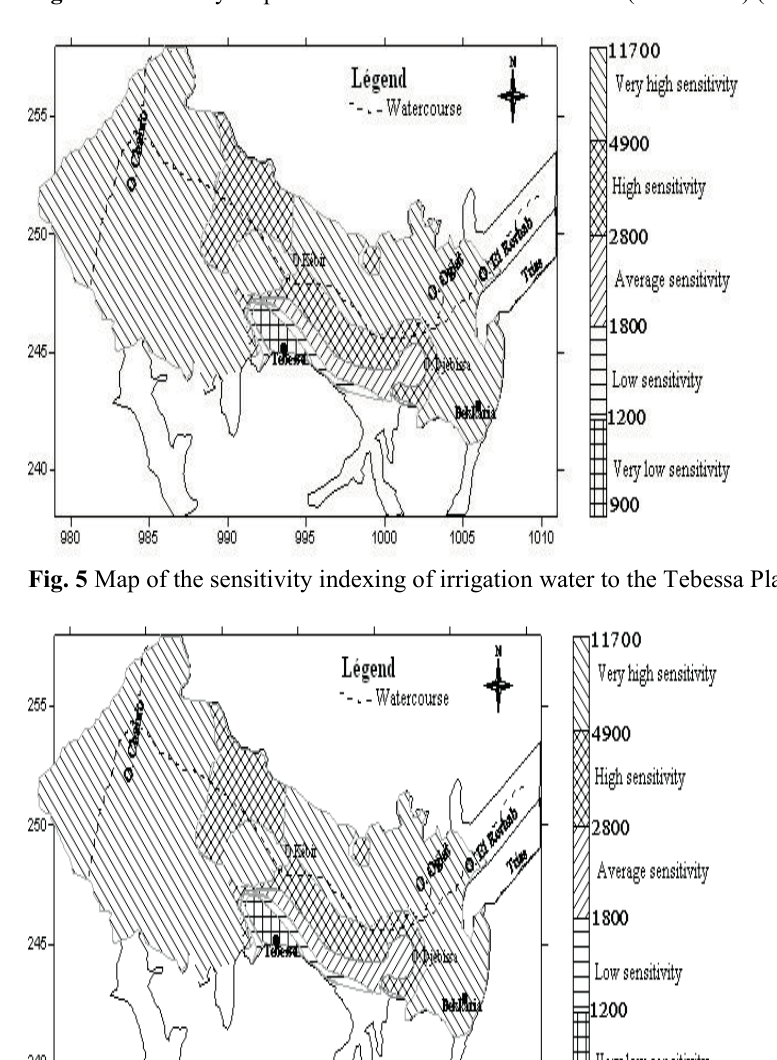
Fig. 4 Vulnerability map of the waters of the Tebessa Plain (DRASTIC) (Djabri 2008).